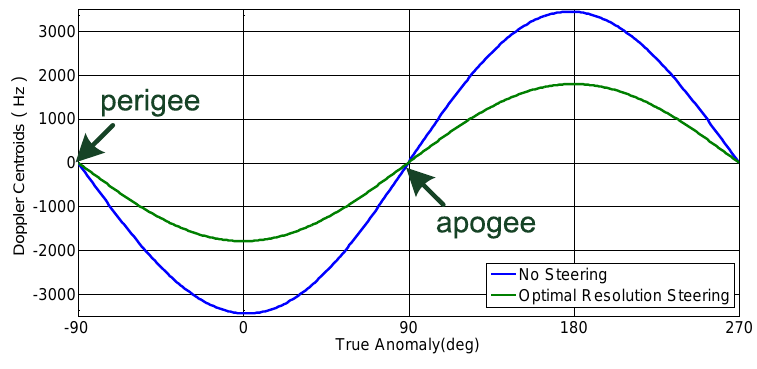
Figure 3. Doppler centroid shifts along the GEO SAR